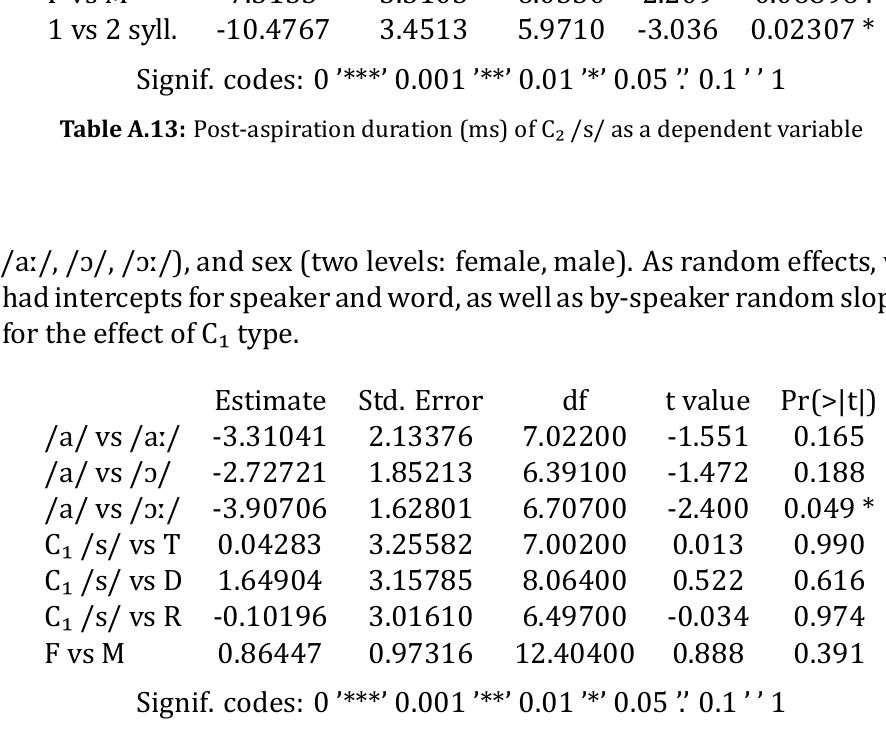
Table A.15: Breathiness occurrence prior to C₂ /s/ as a dependent